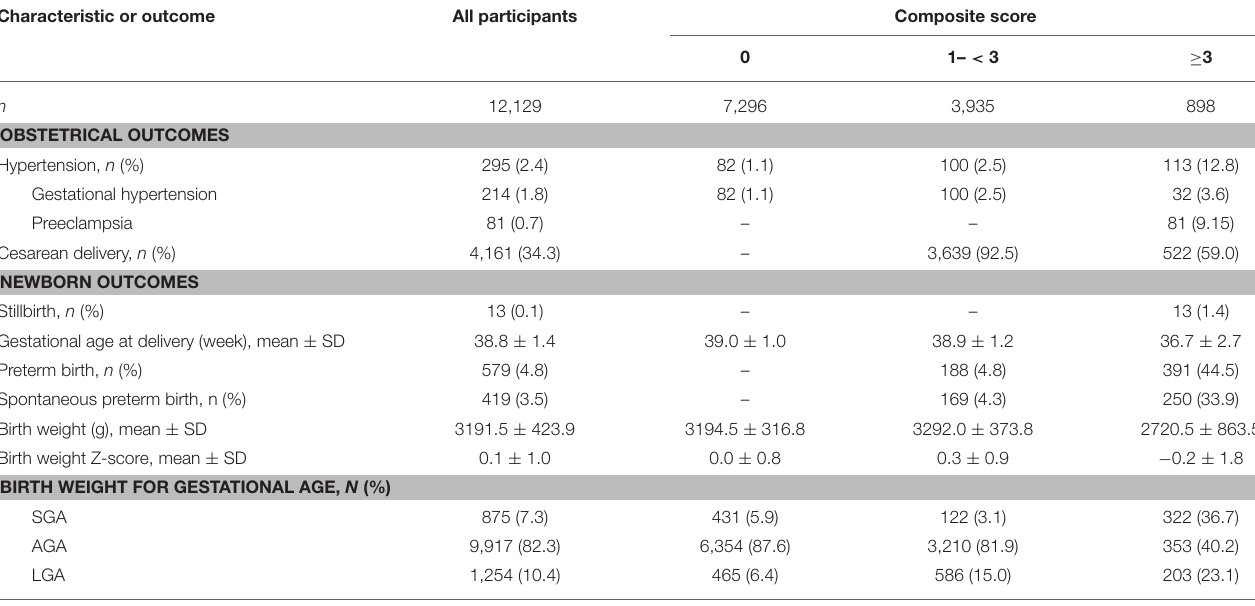
TABLE 3 | Obstetrical and newborn outcomes of the 12,129 study participants. Characteristic or outcome All participants